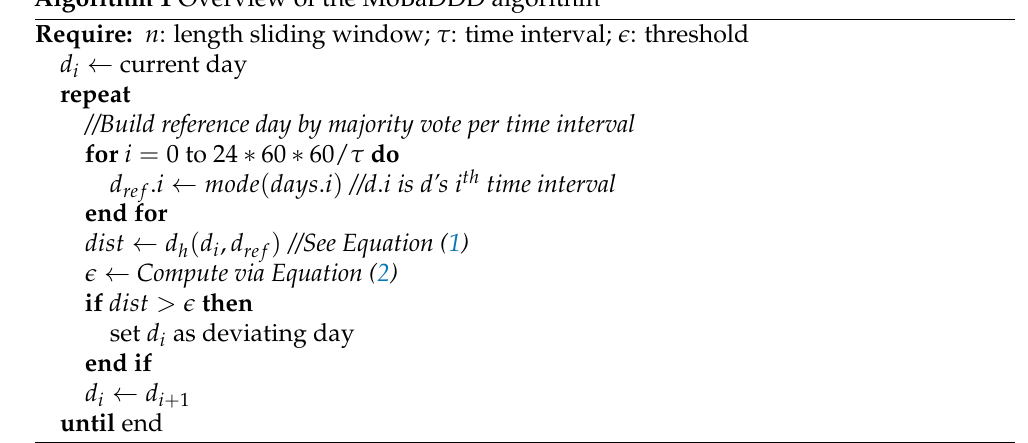
Algorithm 1 Overview of the MoBaDDD